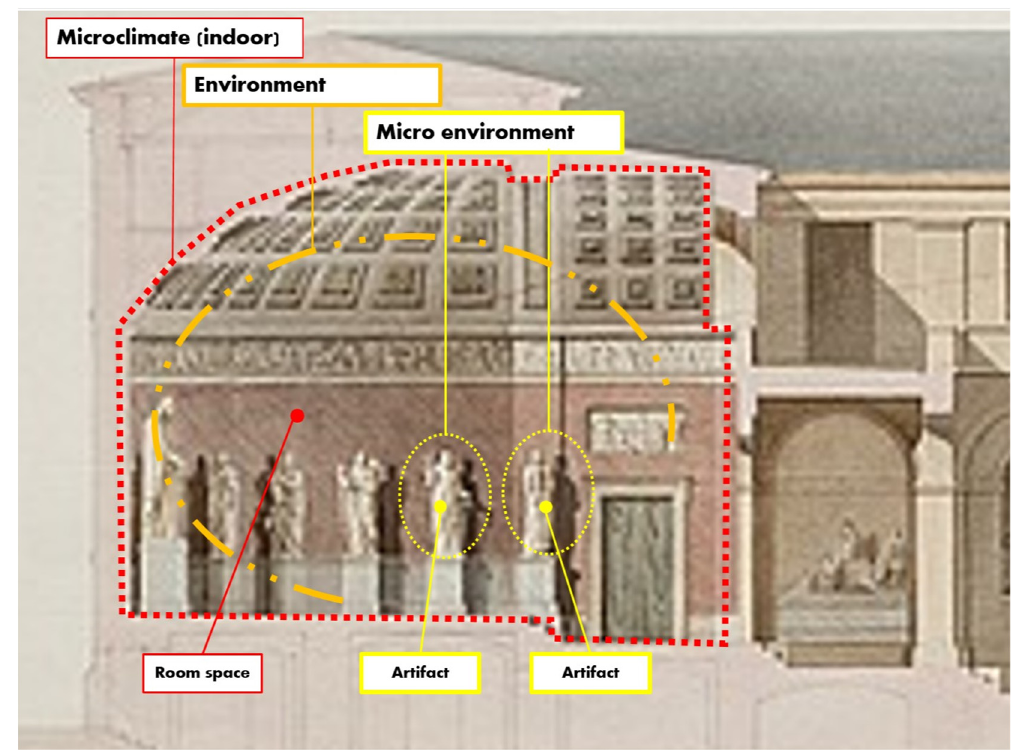
Figure 2. Hierarchy between microclimate, environment e micro ‐ environment.